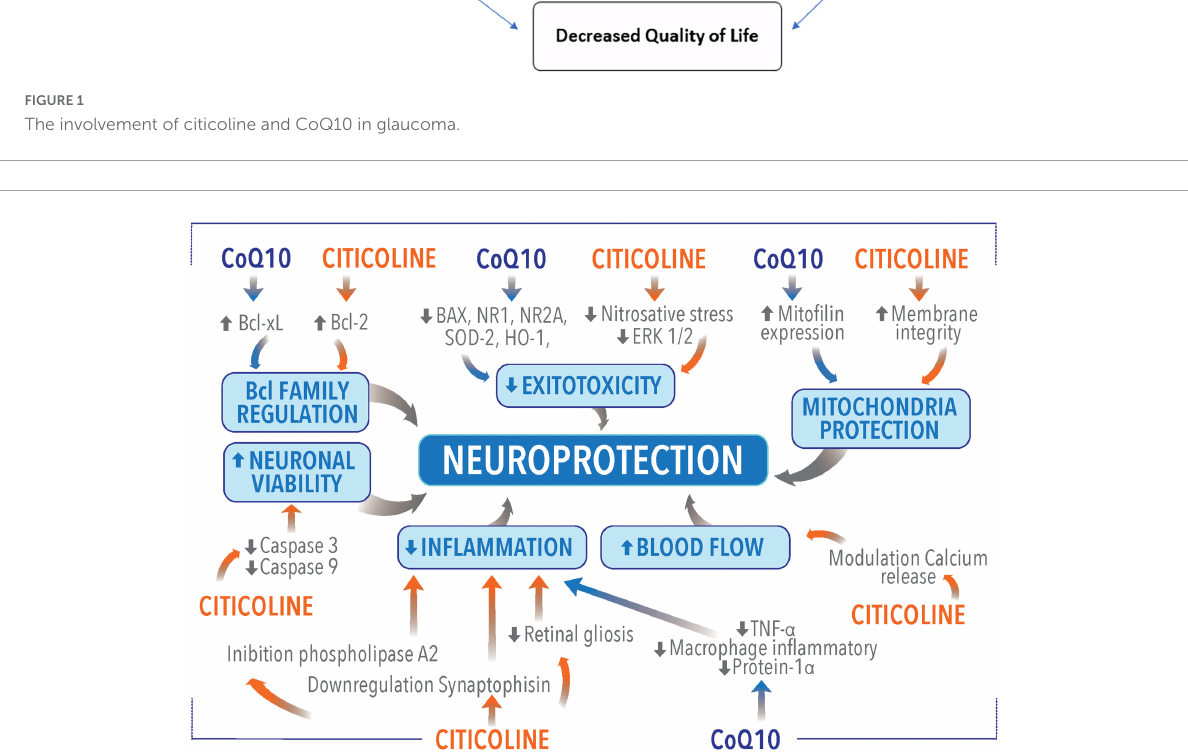
FIGURE2 Neuroprotective molecular mechanisms of coenzyme Q10 (CoQ10) and